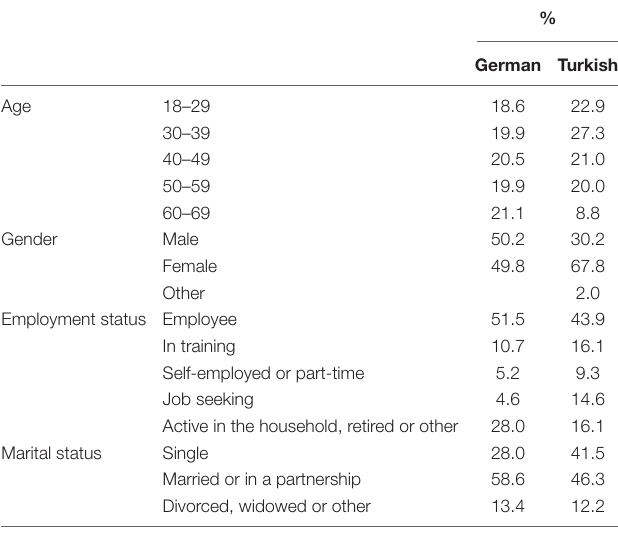
TABLE 1 | Participant demographics.